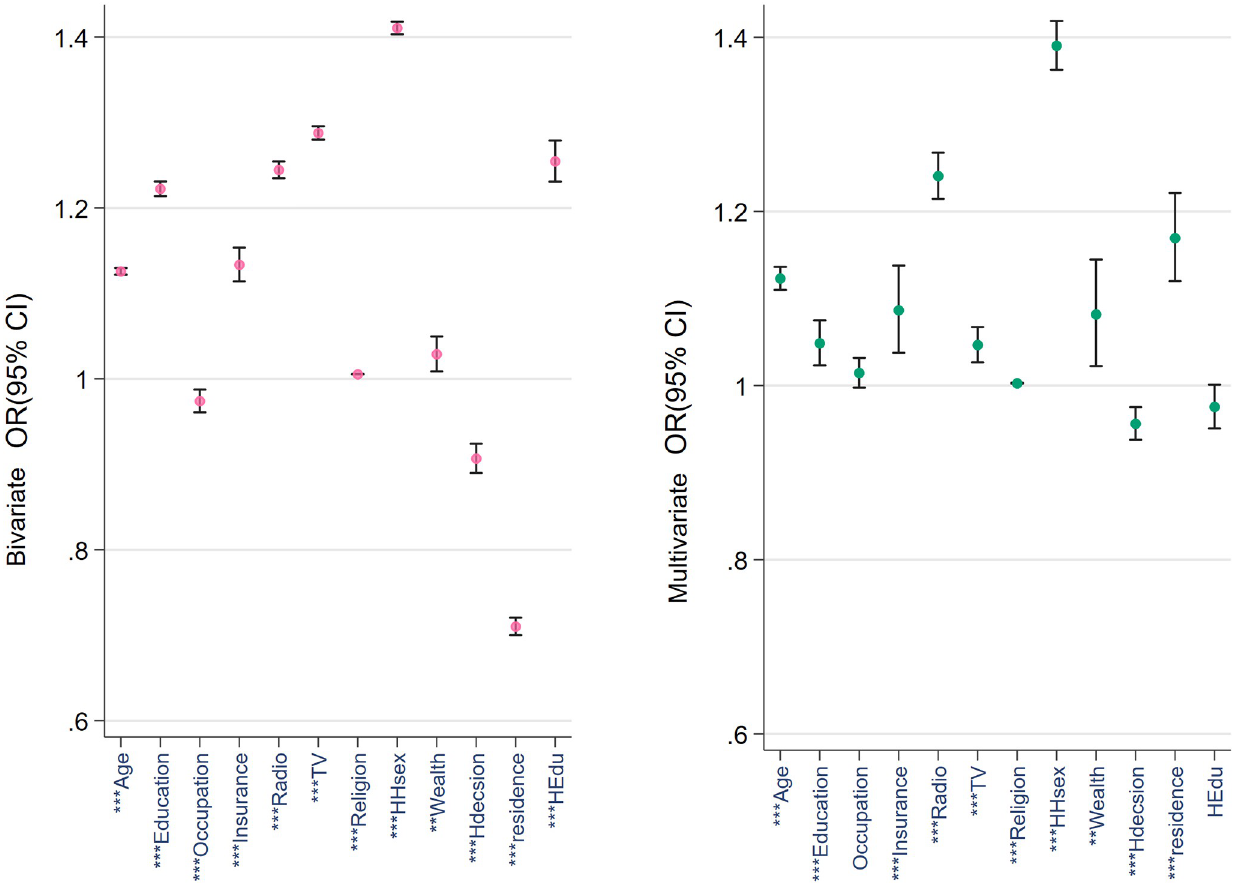
Fig 3. Bivariable and multivariable correlation among breast oral cavity test and the covariables. N.B.: � p < 0.05, �� p < 0.01, ��� p < 0.001. HHsex = household head’s sex; Hdecision = healthcare decision maker, HEdu = husband’s education.